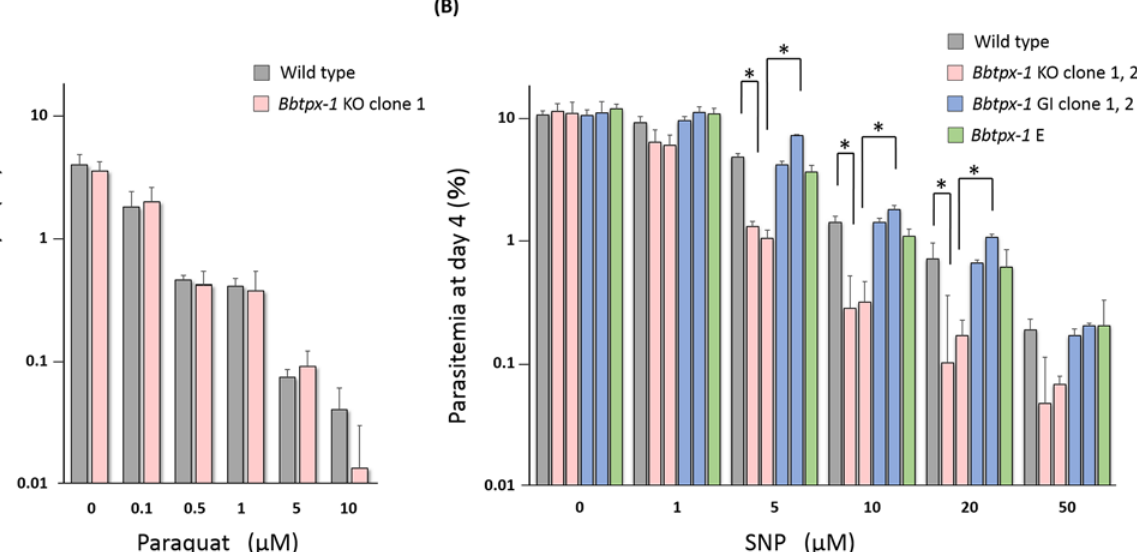
Fig 6. Sensitivity of the parental wild type (WT) parasites, Bbtpx-1 KO (KO), Bbtpx-1 genome integrant (GI), and Bbtpx-1 episomal transfectant (E) to paraquat and SNP. (A) Sensitivity of the Bbtpx-1 KO parasites to paraquat. Bbtpx-1 KO parasites and parental wild type parasites were cultured in the medium with 0, 0.1, 0.5, 1, 5 and 10 μ M paraquat. The cultures were initiated with 0.1% parasitemia and parasitemias at day 4 were plotted. (B) Sensitivity of the Bbtpx-1 KO and Bbtpx-1 complemented parasites to SNP. The parasites were cultured in the medium with 0, 1, 5, 10, 20 and 50 μ M SNP. Two clones